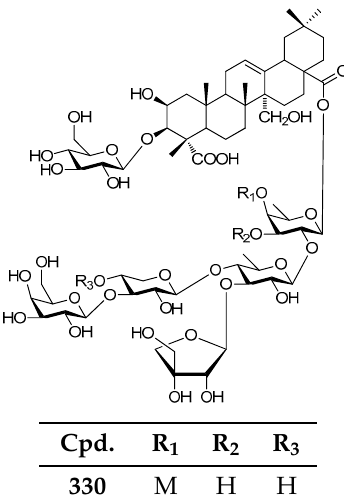
Figure 69. Structure of compound 330 .